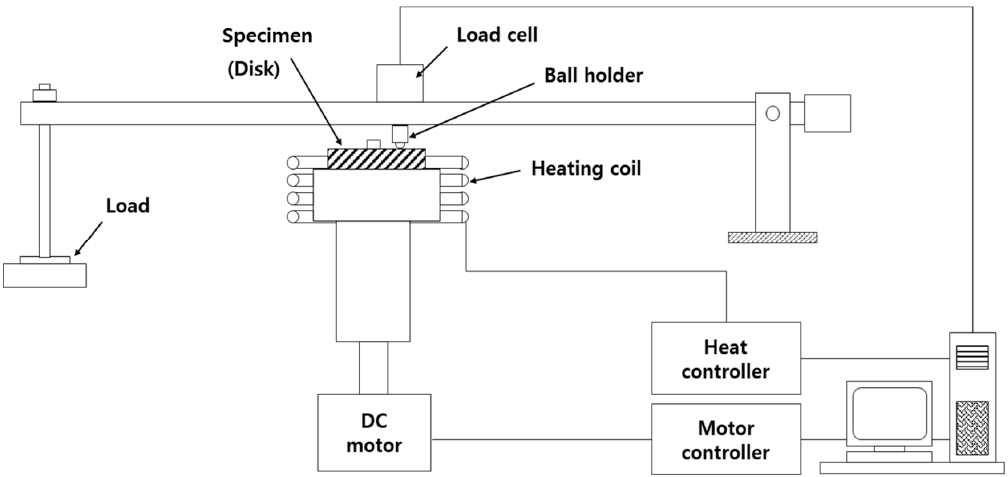
Figure 7. Schematic of the wear test devices.